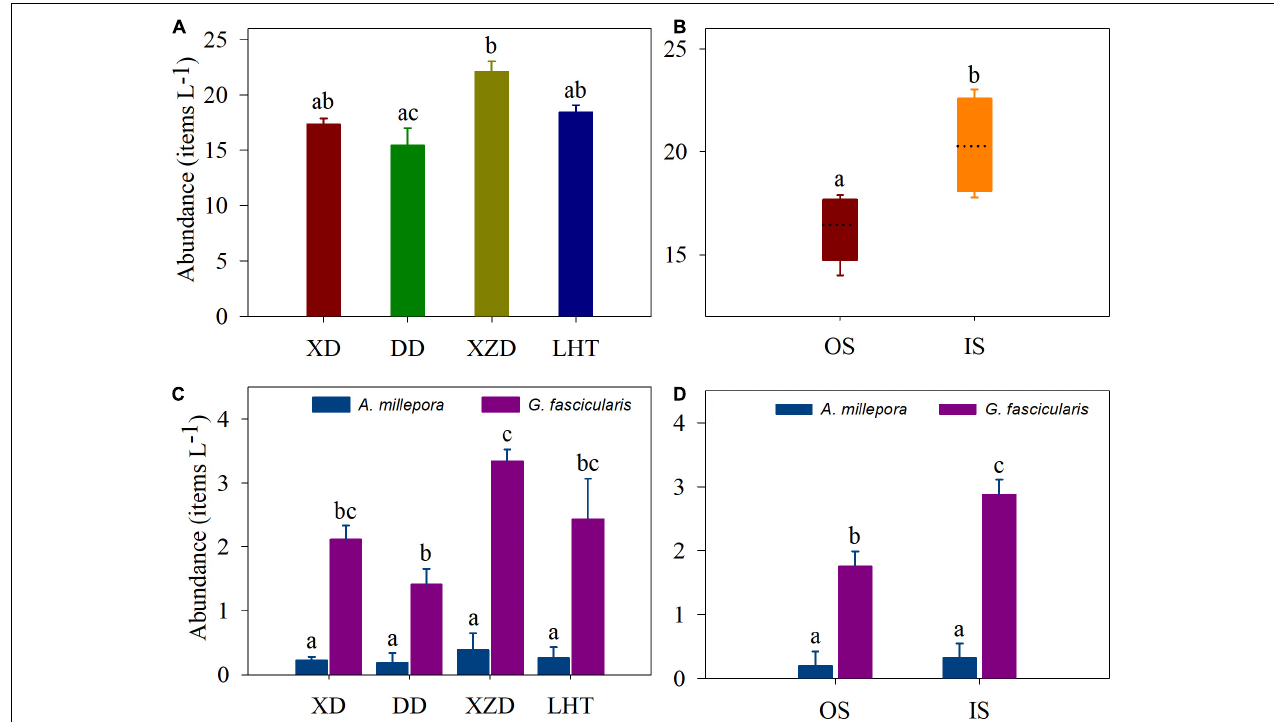
FIGURE 2 | MPs abundance in seawater (A,B) and corals (C,D) . XD, Xidao; DD, Dongdao; XZD, Xiaozhoudao; LHT, Luhuitou. Shared letters above the bars indicate there were not statistically different as determined by Tukey’s HSD post hoc test.